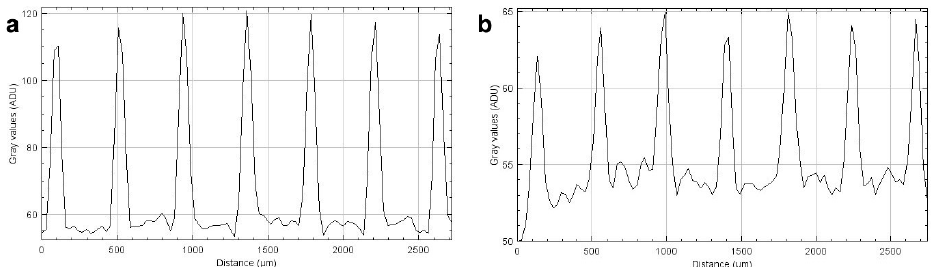
Figure 2. Horizontal intensity profiles form MBI peak doses of 40 Gy ( a ) and 400 Gy ( b ), obtained from HD-V2 Gafchromic™ film scans.